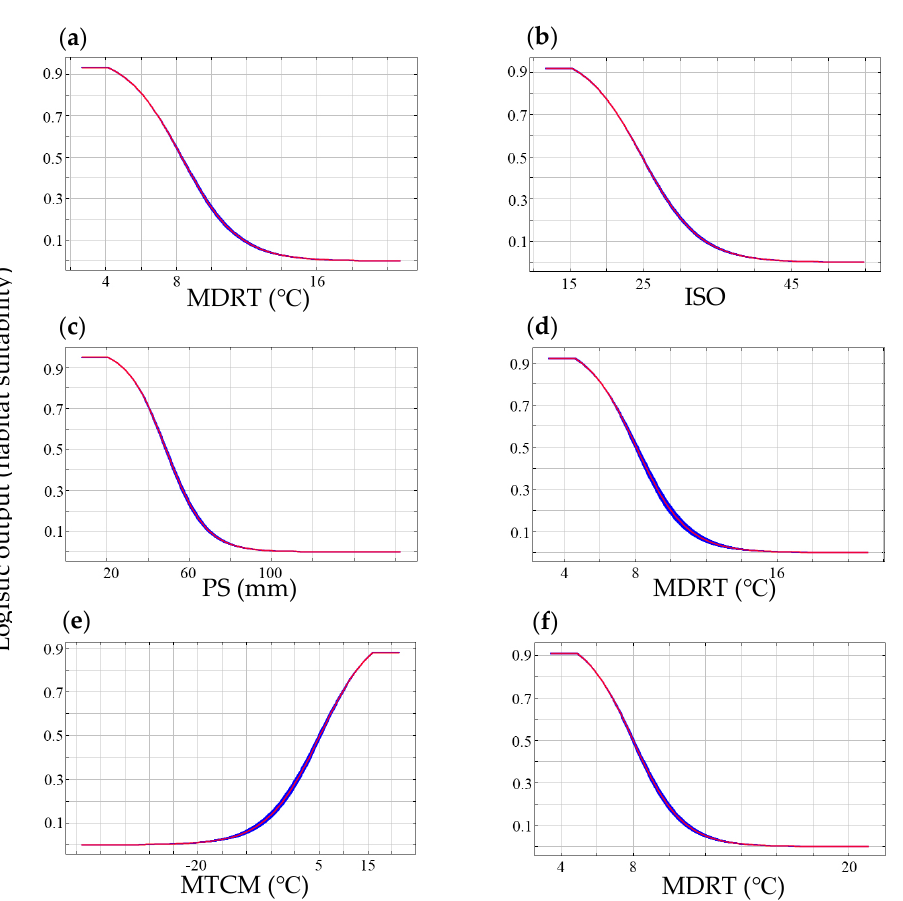
Figure 2. The response curves of species occurrence to the top two influencing variables for C. oblongifolia ( a , b ), C. tientaiensis ( c , d ), and C. purpurinervis ( e , f ), respectively. The logistic output of SDM (also known as habitat suitability) is represented by the vertical Y —axis and the environmental variable by the horizontal X —axis. When the logistic output value is greater than 0.5, the probability of species presence under this condition is higher than that under a ‘typical’ condition, which indicates that the condition is highly suitable for the tree species. The red curves were the averages over 15 replicate runs; blue margins showed ± 1 standard deviation (SD) calculated over 15 replicates.